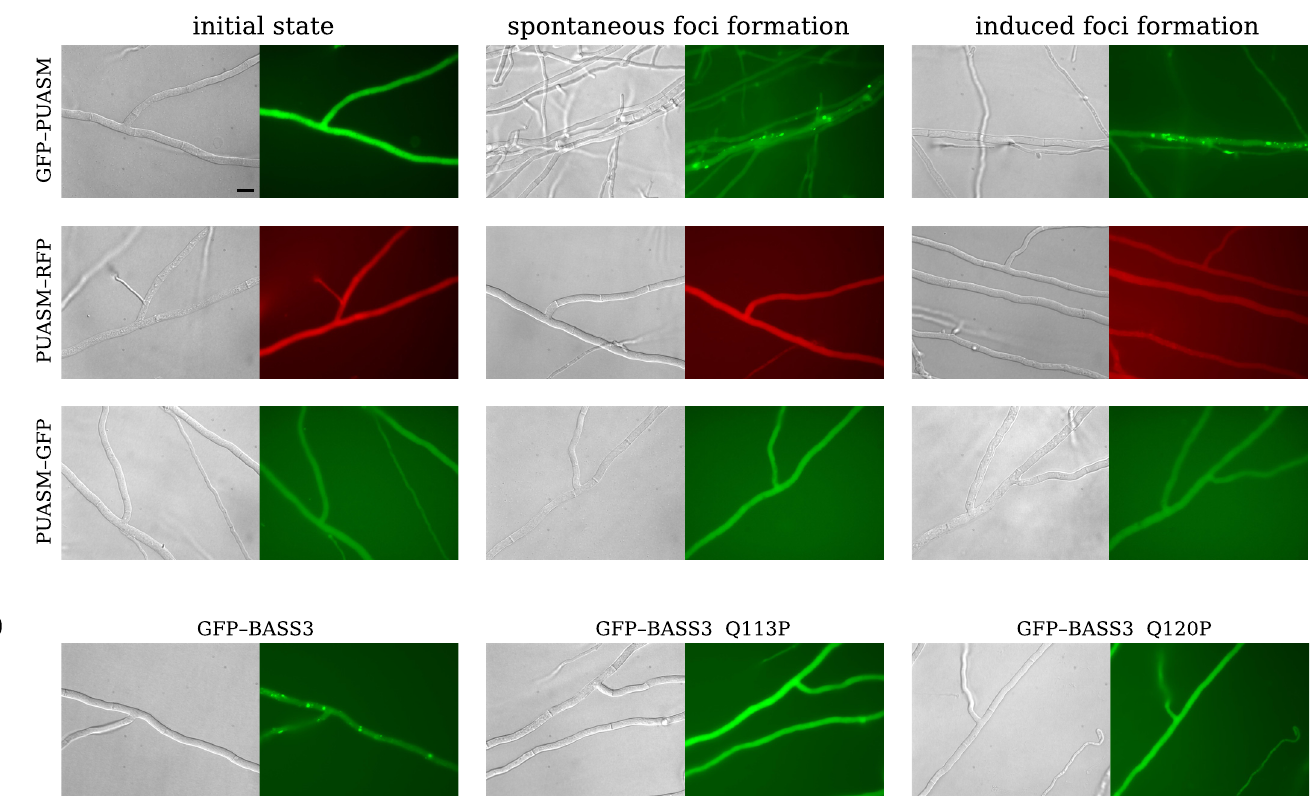
Fig 6. Expression of GFP/RFP-fused PUASM motifs in Podospora anserina . a ) Micrographs of P. anserina strains expressing molecular fusions of PUASM with GFP or RFP, as indicated on the left; scale bar: 5 μ m. Strains were analyzed in their initial state after transfection (left panels marked) and either after several days of subculturing (middle panels, spontanous foci formation) or after cytoplasmic contact with a strain expressing GFP–PUASM in the foci state (right panels, induced foci formation). Note that the GFP–PUASM construct (but not PUASM–RFP and PUASM–GFP) leads to spontaneous and induced foci-formation. Quantification of the rate of foci formation is given in Table F in S1 Text. b ) Micrographs of strains expressing GFP–BASS3—positive control for the spontanous foci formation (BASS3 motif of WP_037701008.1 of Streptomyces atratus , positions 70 to 124, left panel), and two GFP–BASS3 mutants—negative controls ( Q113P , middle, and Q120P , right panel).